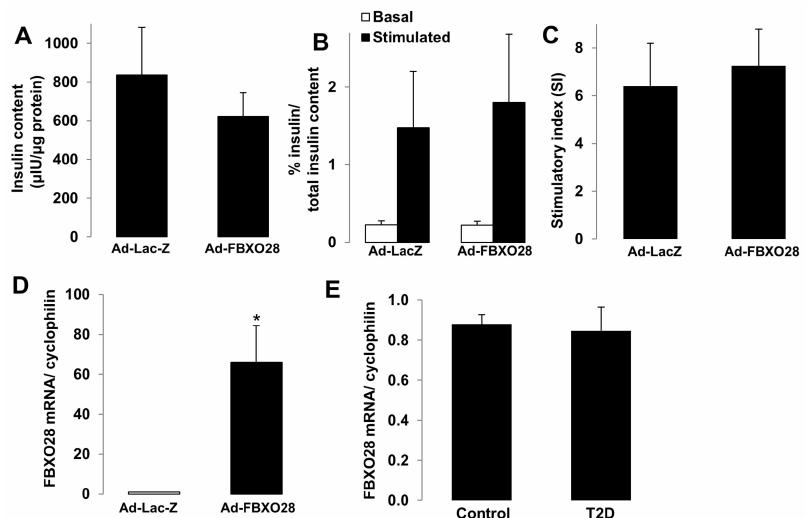
Figure 4. FBXO28 does not improve β -cell function in T2D human islets and FBXO28 mRNA expression is unchanged in T2D islets. ( A – D ) Similar to non-diabetic human islets in Figure 3, freshly isolated human islets from patients with type 2 diabetes (T2D) were infected with LacZ control or FBXO28 adenoviruses for 1 day. ( A ) Insulin content analyzed after GSIS and normalized to whole islet protein; ( B ) Insulin secretion during 1 h-incubation with 2.8 mM (basal) and 16.7 mM glucose (stimulated), normalized to insulin content; ( C ) The insulin stimulatory index denotes the ratio of secreted insulin during 1 h-incubation with 16.7 mM and 2.8 mM glucose; ( D ) FBXO28 mRNA expression in human T2D islets; ( E ) RT-PCR for FBXO28 mRNA expression in human islets isolated from nondiabetic ( n = 24) or individuals with T2D ( n = 7), normalized to Cyclophilin. ( A – D ) Pooled data are from five independent experiments from five different human islet donors with confirmed T2D. Data show means ± SEM. * p < 0.05 compared to